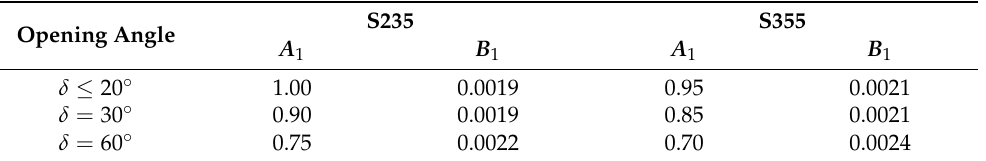
where σ x , Rd is the axial design buckling stress calculated based on the EN1993-1-6 stan- EC dard [24] and C 1 is the strength reduction factor calculated using Equation (5) and the coefficients of Table 2. Table 2. Coefficients 𝐴 (cid:2869) and 𝐵 (cid:2869) for reduction factor 𝐶 (cid:2869) [26]. Table 2. Coefficients A 1 and B 1 for reduction factor C 1 [26]. Opening angle Opening